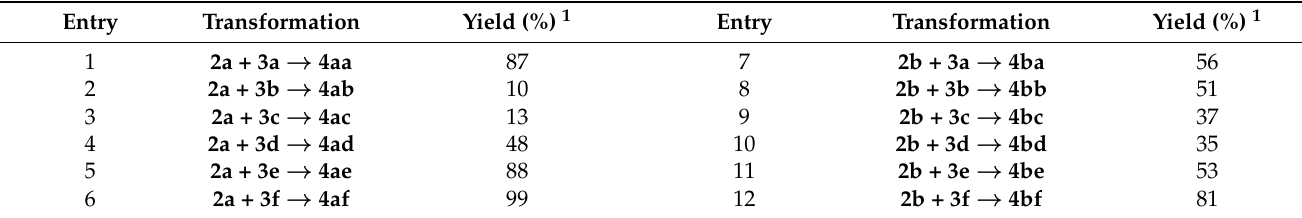
Table 1. Experimental data for compounds 4 .